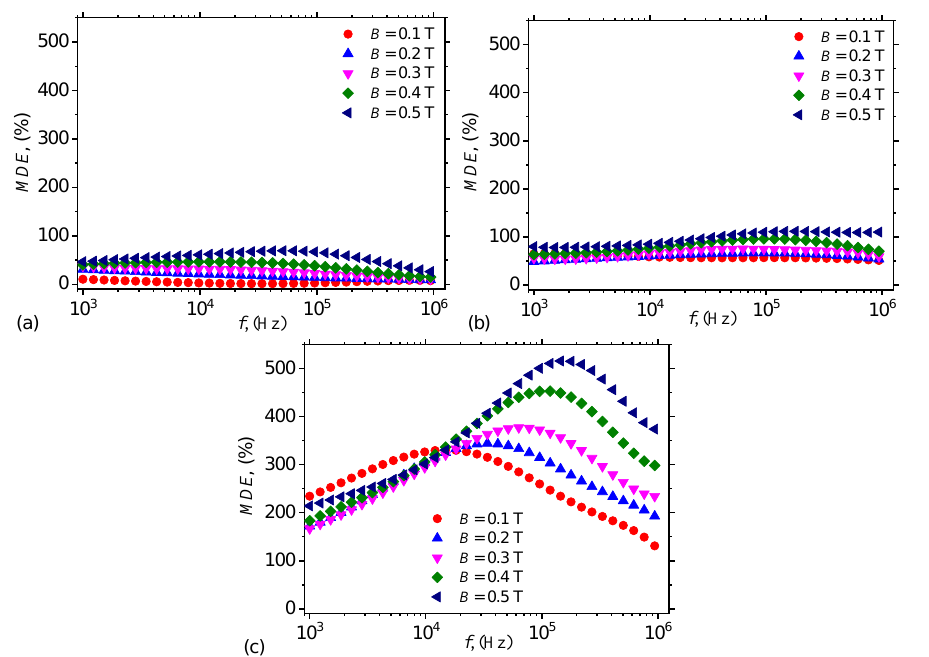
Figure 9. Variation of magnetodielectric effects ( MDEs ) with frequency f , at fixed values of magnetic flux density B . ( a ) hEMAC 1 . ( b ) hEMAC 2 . ( c ) hEMAC 3